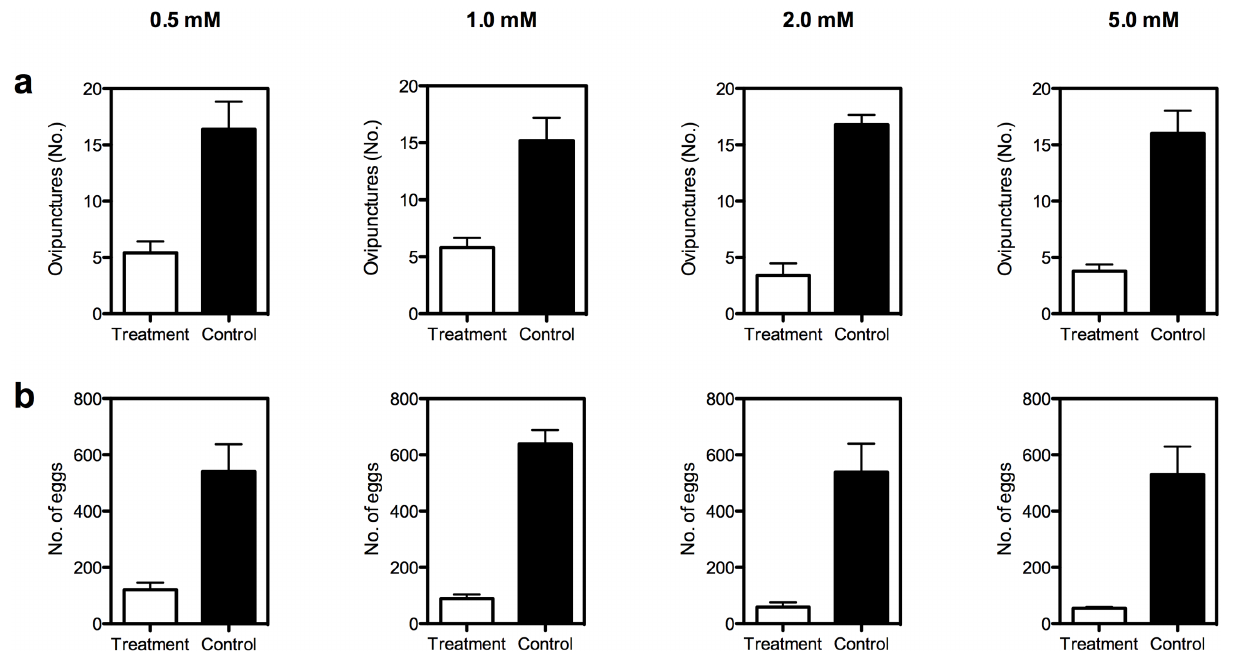
Fig 1. Effect of salicylic acid (SA) on the oviposition of B . dorsalis . (a) punctures (b) Eggs per puncture. Decreased number of punctures and eggs were recorded in SA treated fruit when compared to the control fruit. (paired t test, ovipunctures (0.5 mM: t = 7.59, df = 4, P = 0.002; 1.0 mM: t = 3.81, df = 4, P = 0.02; 2.0mM: t = 11.49, df = 4, P = 0.0003; 5mM: t = 6.89, df = 4, P = 0.002); eggs per puncture (0.5 mM: t = 5.15, df = 4, P = 0.01; 1.0 mM: t = 9.57, df = 4, P = 0.001; 2.0mM: t = 5.49, df = 4, P = 0.01; 5mM: t = 4.78, df = 4, P = 0.01). Error bars = Standard error of